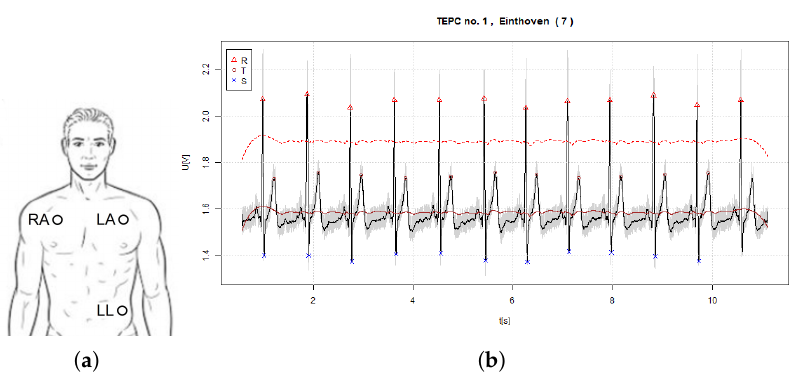
Figure 5. Three-electrode system for monitoring ECG, containing right arm (RA), left arm (LA), and left leg (LL) electrodes in standard positions ( a ) and an example of the acquired signal of ECG (where the continuous red line denotes the baseline and dashed red line 60% threshold level) ( b ).